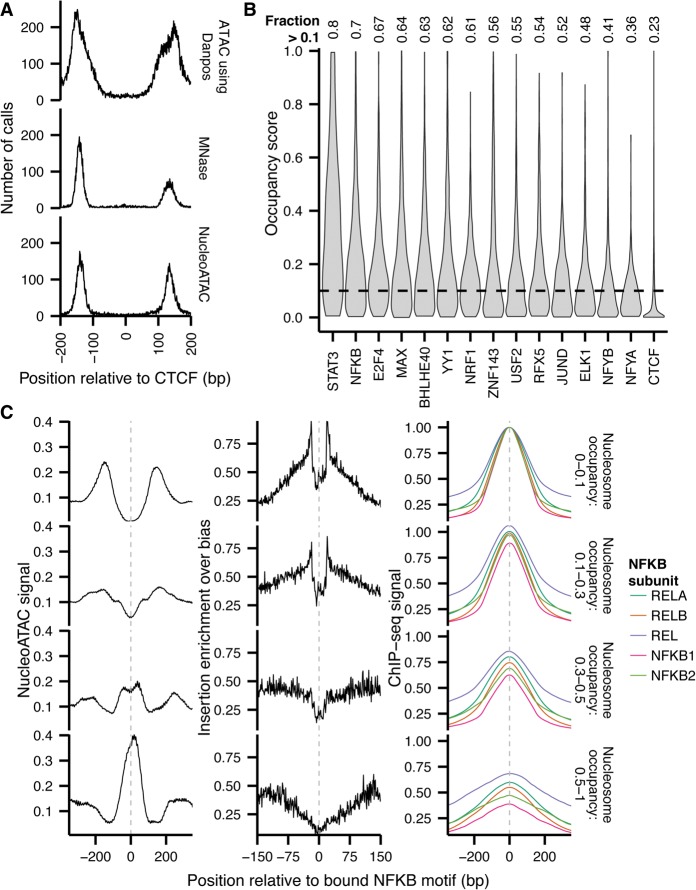
NucleoATAC defines stereotyped TF-nucleosome relationships. (A) Nucleosome dyad density relative to CTCF binding site for nucleosomes called previously with DANPOS (top), MNase (middle), or NucleoATAC (bottom). (B) Nucleosome occupancy distributions for sequence-specific TFs. (C) NucleoATAC nucleosome signal (left), ATAC-seq insertion profile (middle), and NFKB subunit ChIP-seq signal for NFKB at sites with different nucleosome occupancies (right). Insertion frequency normalized by sequence bias model. ChIP-seq intensities for each subunit were normalized such that the maximum intensity for the sites with 0 to 0.1 nucleosome occupancy was 1.